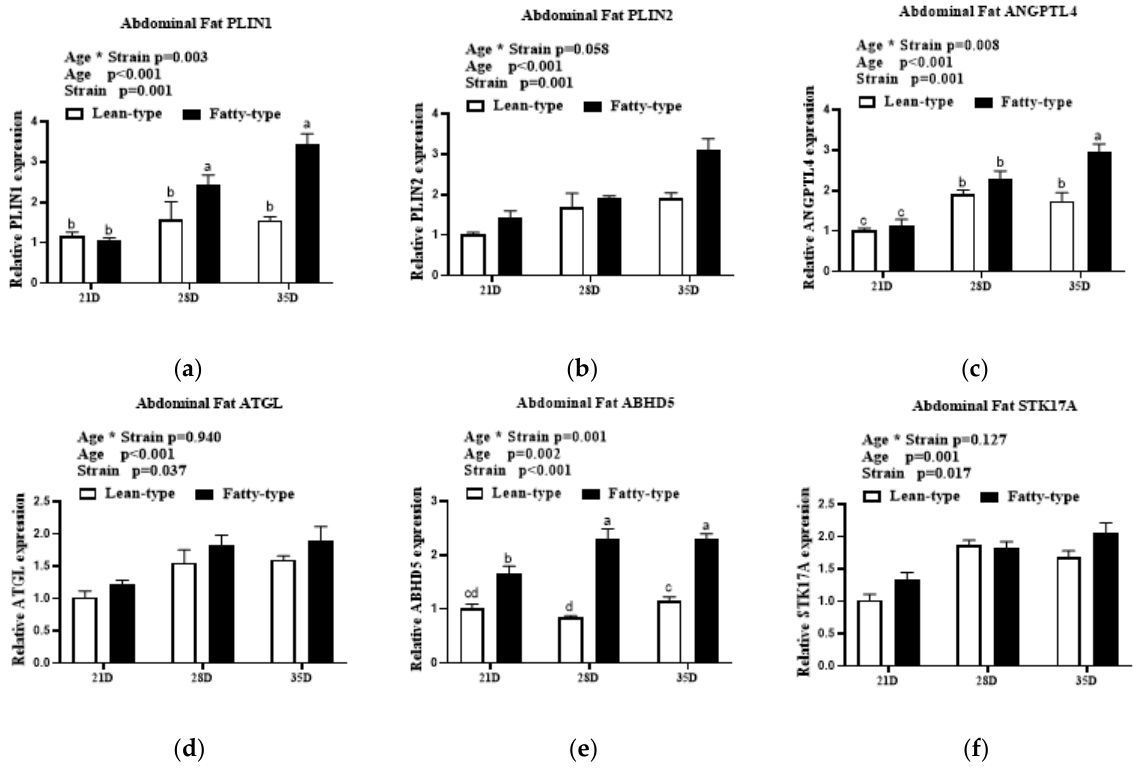
Figure 6. Comparison of expression levels of lipid droplet anabolism genes in abdominal fat ( a – f ) at 21 D, 28 D, and 35 D between two strains of meat ducks. Data are given as means and standard error of the mean ( n = 6). Bars with different letters are significantly different ( p < 0.05). * In the figure represents the interaction between the two factors. Abbreviations: PLIN1 , perilipin 1; PLIN2 , perilipin 2; ANGPTL4 , angiopoietin-like protein 4; ATGL , adipose triglyceride lipase; ABHD5 , abhydrolase domain containing 5; STK17A ; serine/threonine kinase 17a.